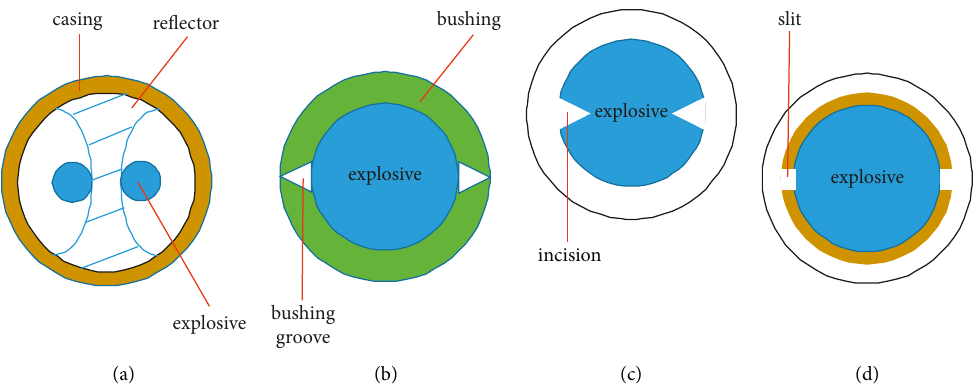
Figure 3: Schematic diagram of the energy gathering structure [12].